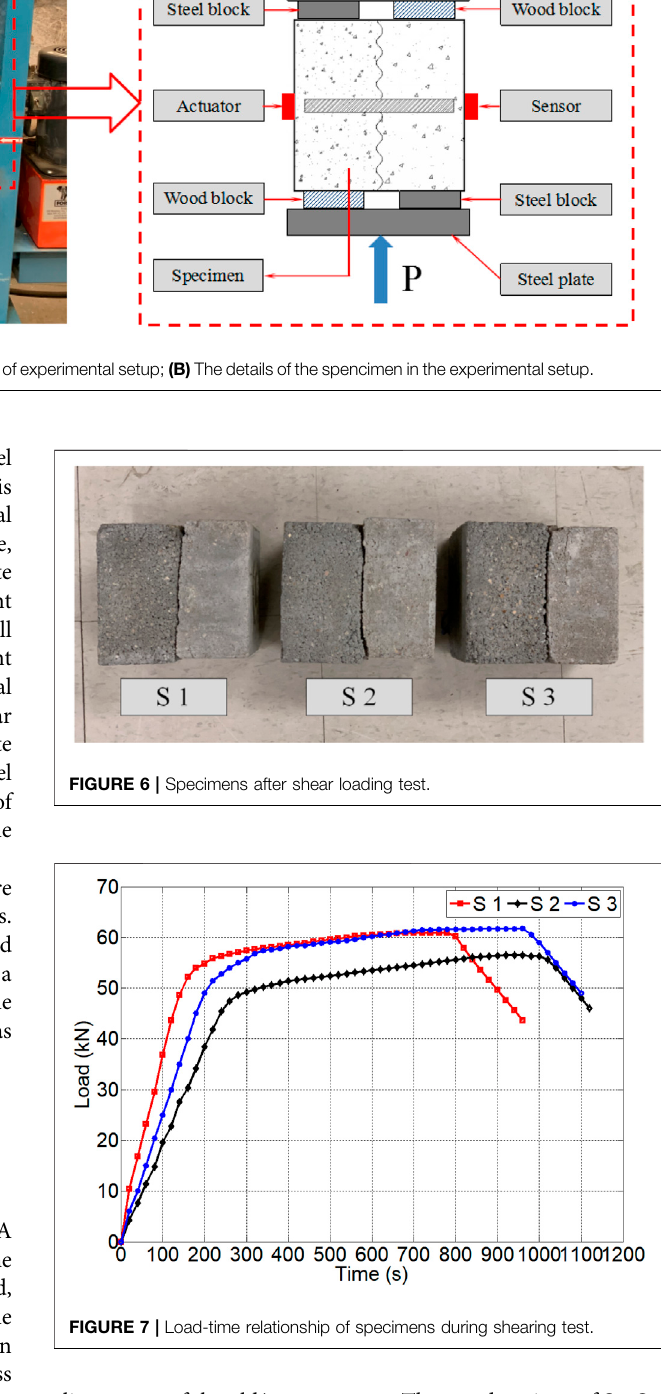
FIGURE 7 | Load-time relationship of specimens during shearing